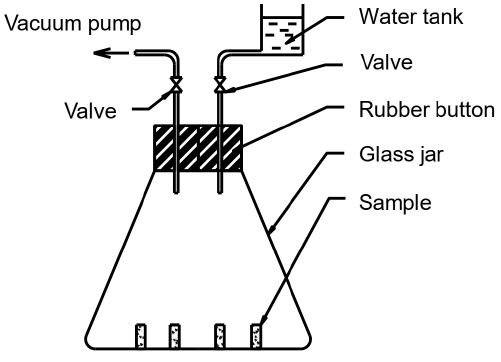
Figure 2. The apparatuses for measuring the open porosity of the sintered porous copper. Additionally, in comparison, ImageJ analysis software (version 1.53t, National Insti- tutes of Health, Bethesda, AR, USA) was also used to assess and identify the total porosity ( γ TP ) of prepared samples on the SEM images. In this method, the distribution of pore areas and the fraction of total pore areas of the sample were determined and exported by ImageJ software. The fraction of total pore areas is assumed to be the same as the total porosity ( γ TP ) of the samples [27,28]. The image processing and analysis were performed step by step as reported by Mazzoli et al. [29]. First, the original SEM image (Figure 3a) was converted into a binary image (Figure 3b) by proper thresholding for the image pro- cessing algorithms. Second, using the precise threshold limits produced the desired binary image; after that, a high-accuracy size measurement was ensured via the image processing method (Figure 3c). The complexity of the measurement of particle sizes and pore areas varies depending on the shape of the particle (pores) and the number of particles (pores) characterized. The number of measurements needs to be sufficient in order to guarantee an acceptable level of uncertainty in the output parameters. In this study, the distributions of the particle sizes and pore areas were acquired by conducting an analysis of more than 20 SEM images for each sample to improve the reliability of